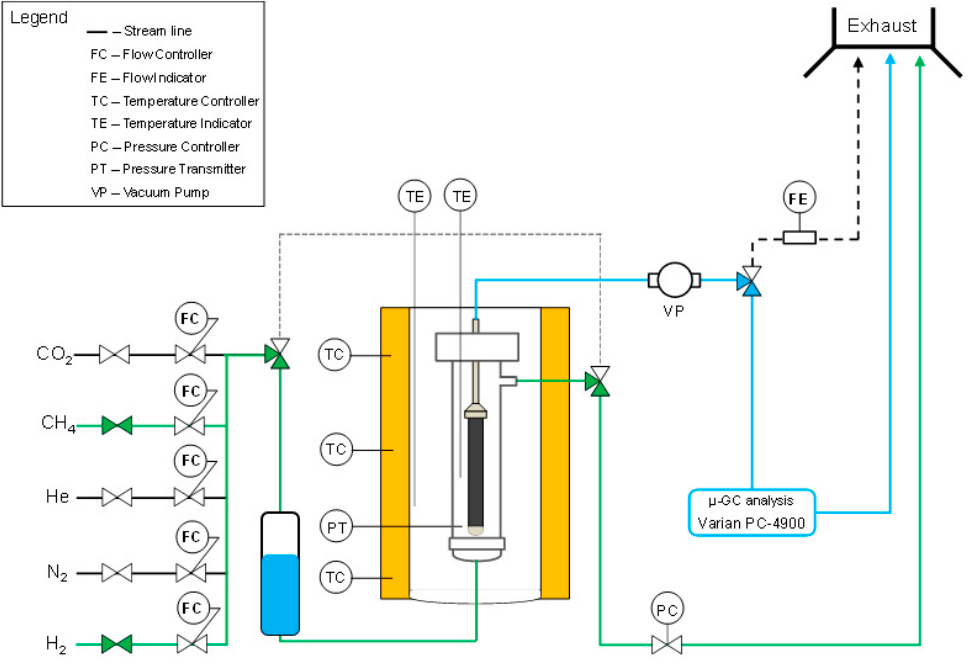
Figure 2. Schematic representation of the high permeation setup.